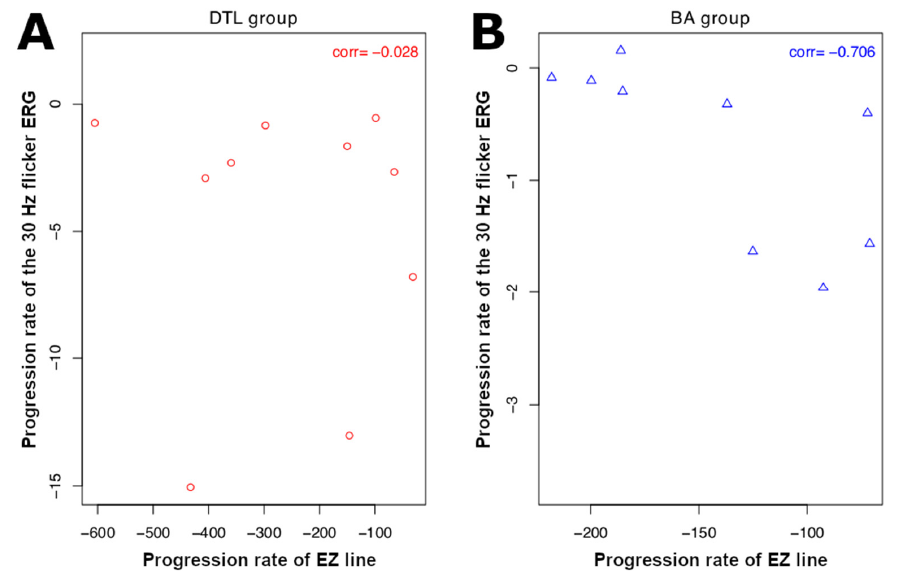
Figure 1. Scatter plots of the progression rate of 30 Hz flicker electroretinogram (ERG) amplitude versus that of ellipsoid zone (EZ) lines: ( A ) progression rates of patients in DTL and ( B ) BA groups. Correlation between progression rates is not significant in DTL group, while in BA group significant negative correlation ( − 0.706) is observed. Here 'corr' at the top-right corner of each subplot denotes correlation coefficient